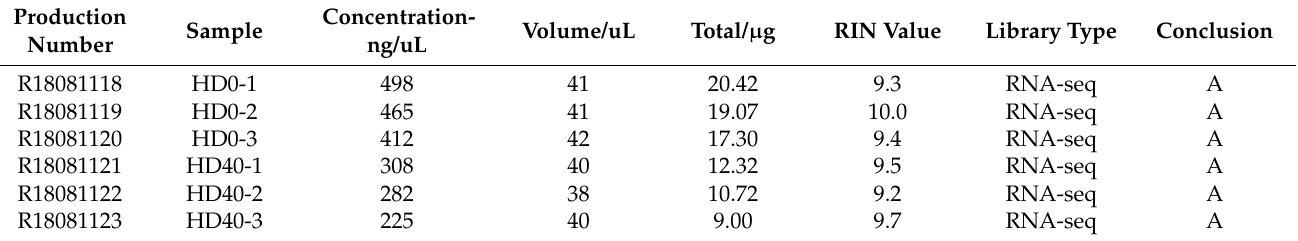
Table 1. The results of RNA extraction